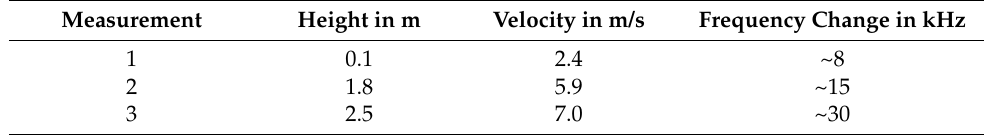
Table 3. Measurement